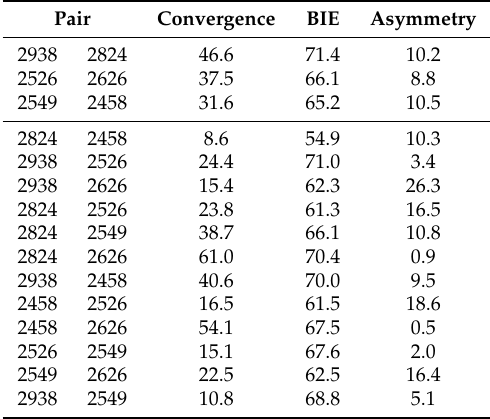
Table 2. List of the WorldView-3 pairs used for DEM extraction and angles describing the acquisition geometry. The first three are the original pairs from the acquisition. Pair Convergence